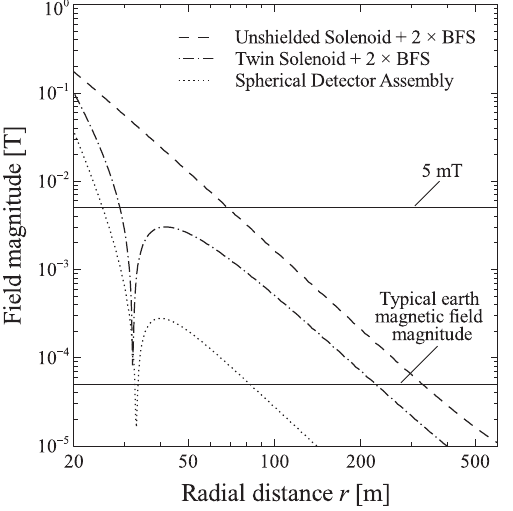
FIG. 13. Magnetic field magnitude as a function of radial distance to the interaction point.